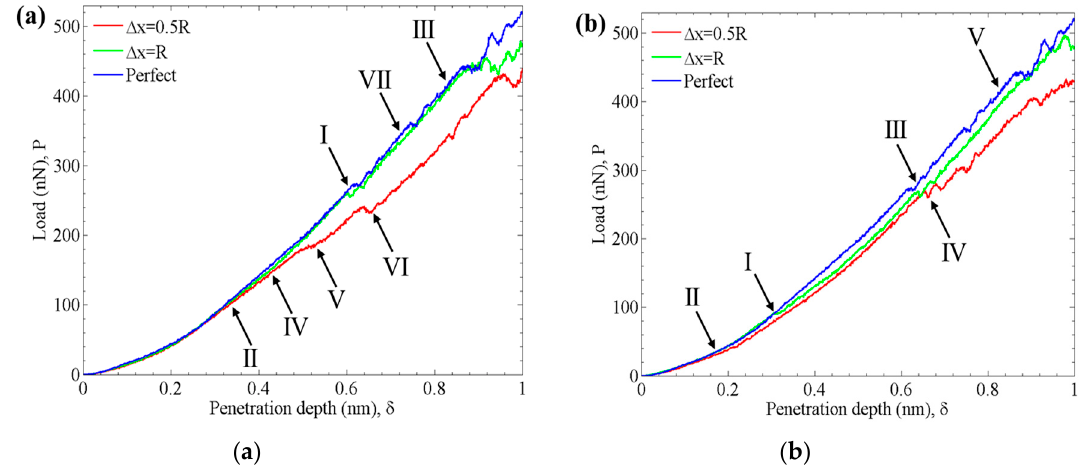
Figure 7. Indentation load as a function of penetration depth for spherical indentation into Cu bicrystals and a Cu single crystal. ( a ) Bicrystal with the dense boundary; and ( b ) bicrystal with the loose boundary. The arrows and Roman numerals are explained in the text.